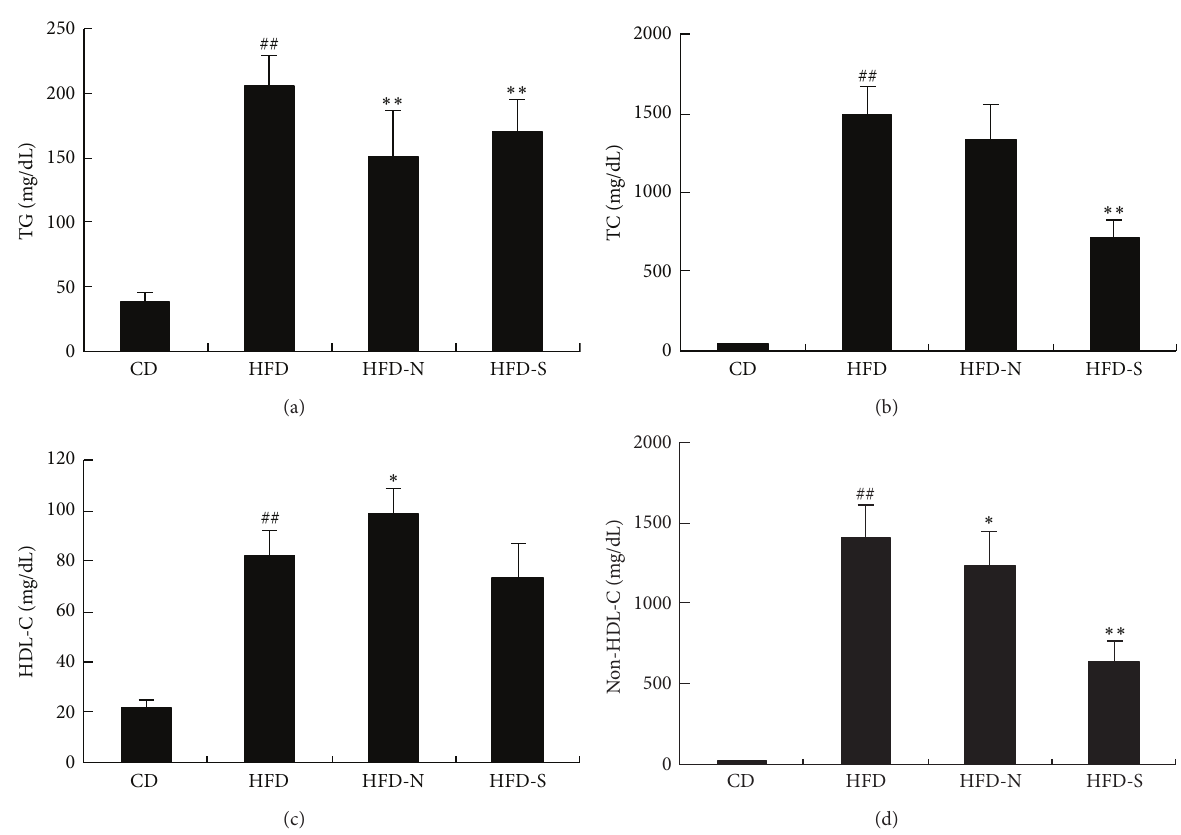
Figure 7: Effect of niacin and simvastatin on plasma lipid of guinea pigs fed high fat diet. The levels of TG (a), TC (b), HDL-C (c), and non-HDL-C (d) in plasma of guinea pigs were determined by enzyme method after 8 weeks’ treatment. Data are presented as mean ± SD ( 𝑛 = 8 ). ## 𝑃 < 0.01 versus CD group; ∗ 𝑃 < 0.05 ; ∗∗ 𝑃 < 0.01 versus HFD group.